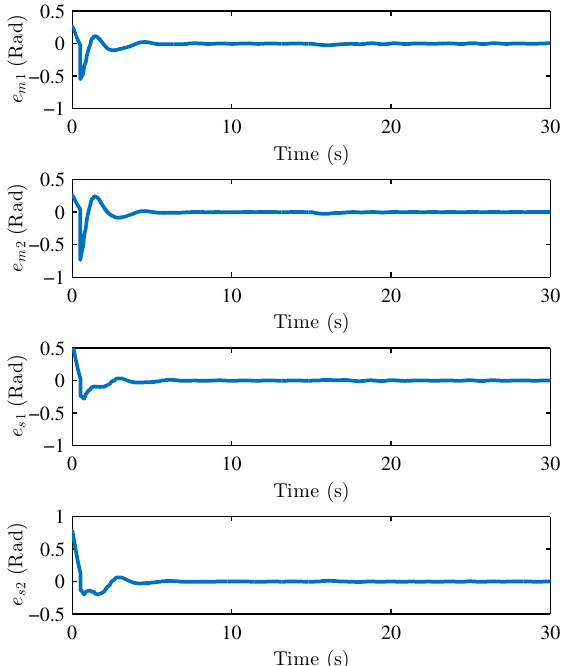
Figure 4. Joint positions of master robot q m 1 , q m 2 and slave robot q s 1 , q s 2 .